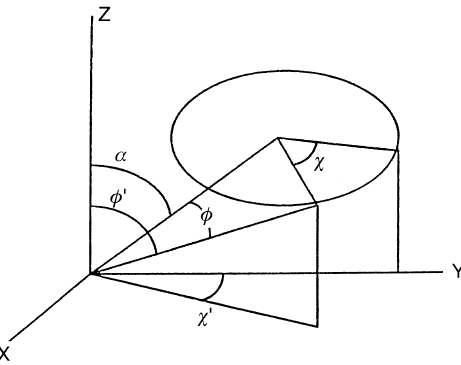
Fig. 1. Geometry of the 3-dimensional